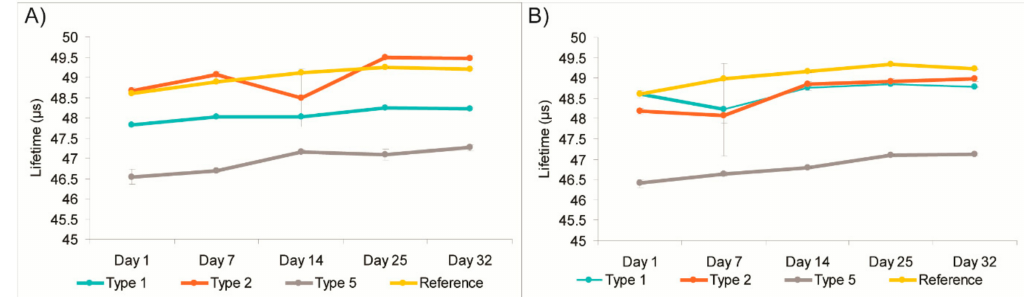
Figure 4. Changes in sensor lifetime signals in: Uupright ( A ); and inverted ( B ) cheese